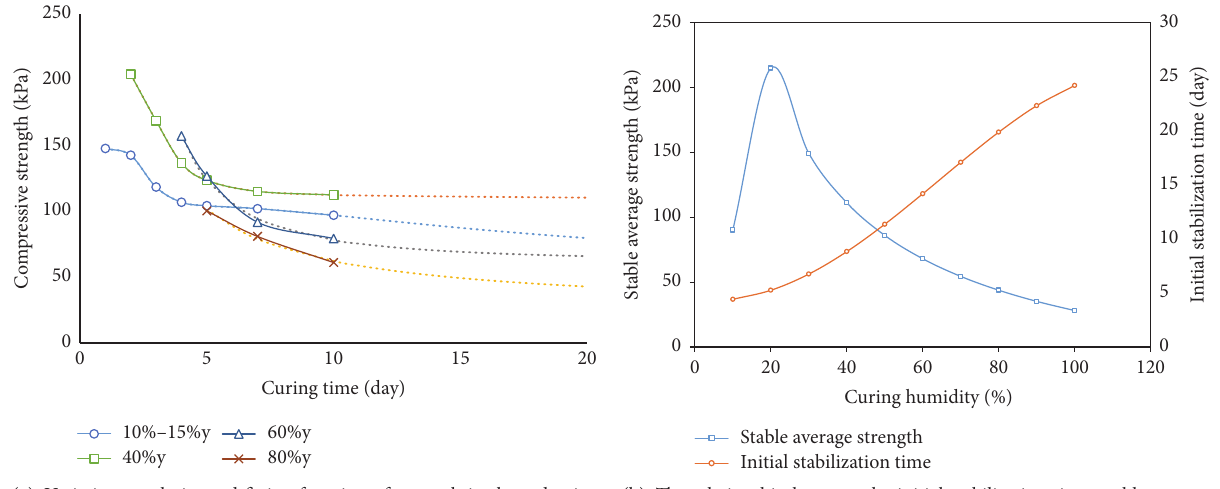
Figure 10: Selection model of the curing method of similar materials.